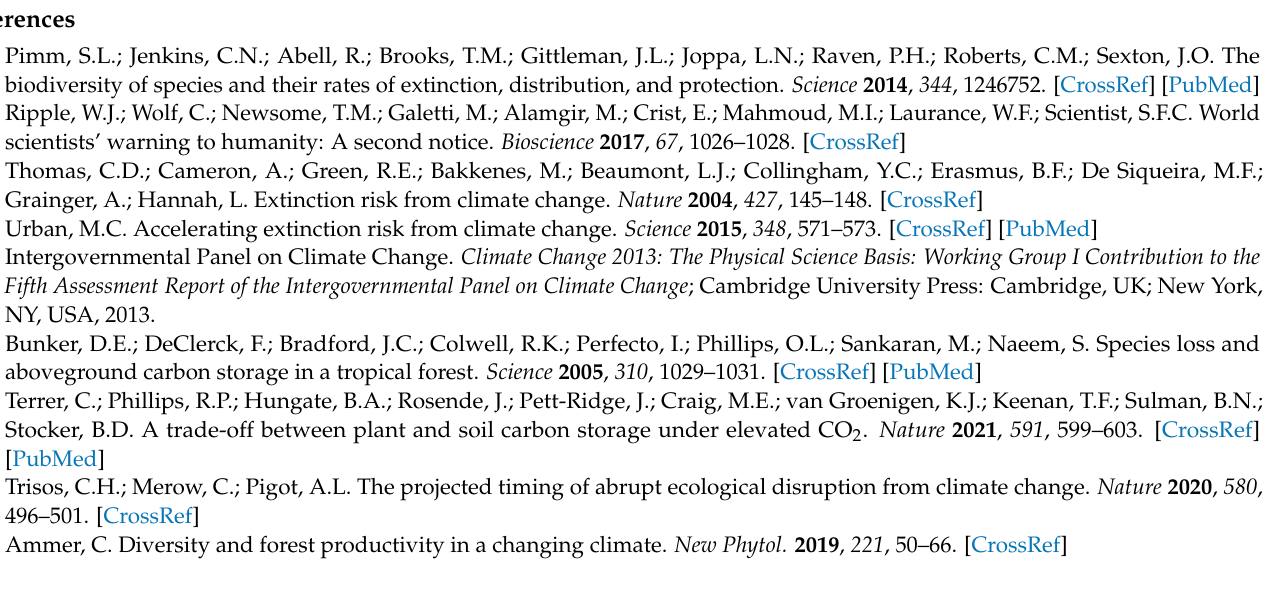
Figure S3: Estimates ( ± 2SE) of neighborhood factors on survival (a) and RGR (b) of all individuals at sapling and adult life stages at 5–30 m; Figure S4: Estimated effects ( ± 2SE) of neighborhood factors on survival and RGR of tree mycorrhizal types at sapling and adult life stages at 5–30 m; Figure S5: Correlations between BA of EcM species (BA EcM ) and BA of AM species (BA AM ) with species diversity ( H , Shannon–Weiner index) (a and e), average RGR (b and f), total BA (c and g) and increment of total BA (d and h); Table S1: 179 focal species used in the analysis of neighborhood effects on survival and growth; Table S2: Optimal scales and c for survival and relative growth rate (RGR) of all individuals and tree mycorrhizal types at sapling and adult life stages at 5–30 m; Table S3: Coefficient estimates of the correlation between BA EcM and BA AM with species diversity, average RGR, total BA and increment of total BA; Table S4: Coefficient estimates of the correlation between the √ square root of R EA ( R EA ) with species diversity, average RGR, total BA and increment of total